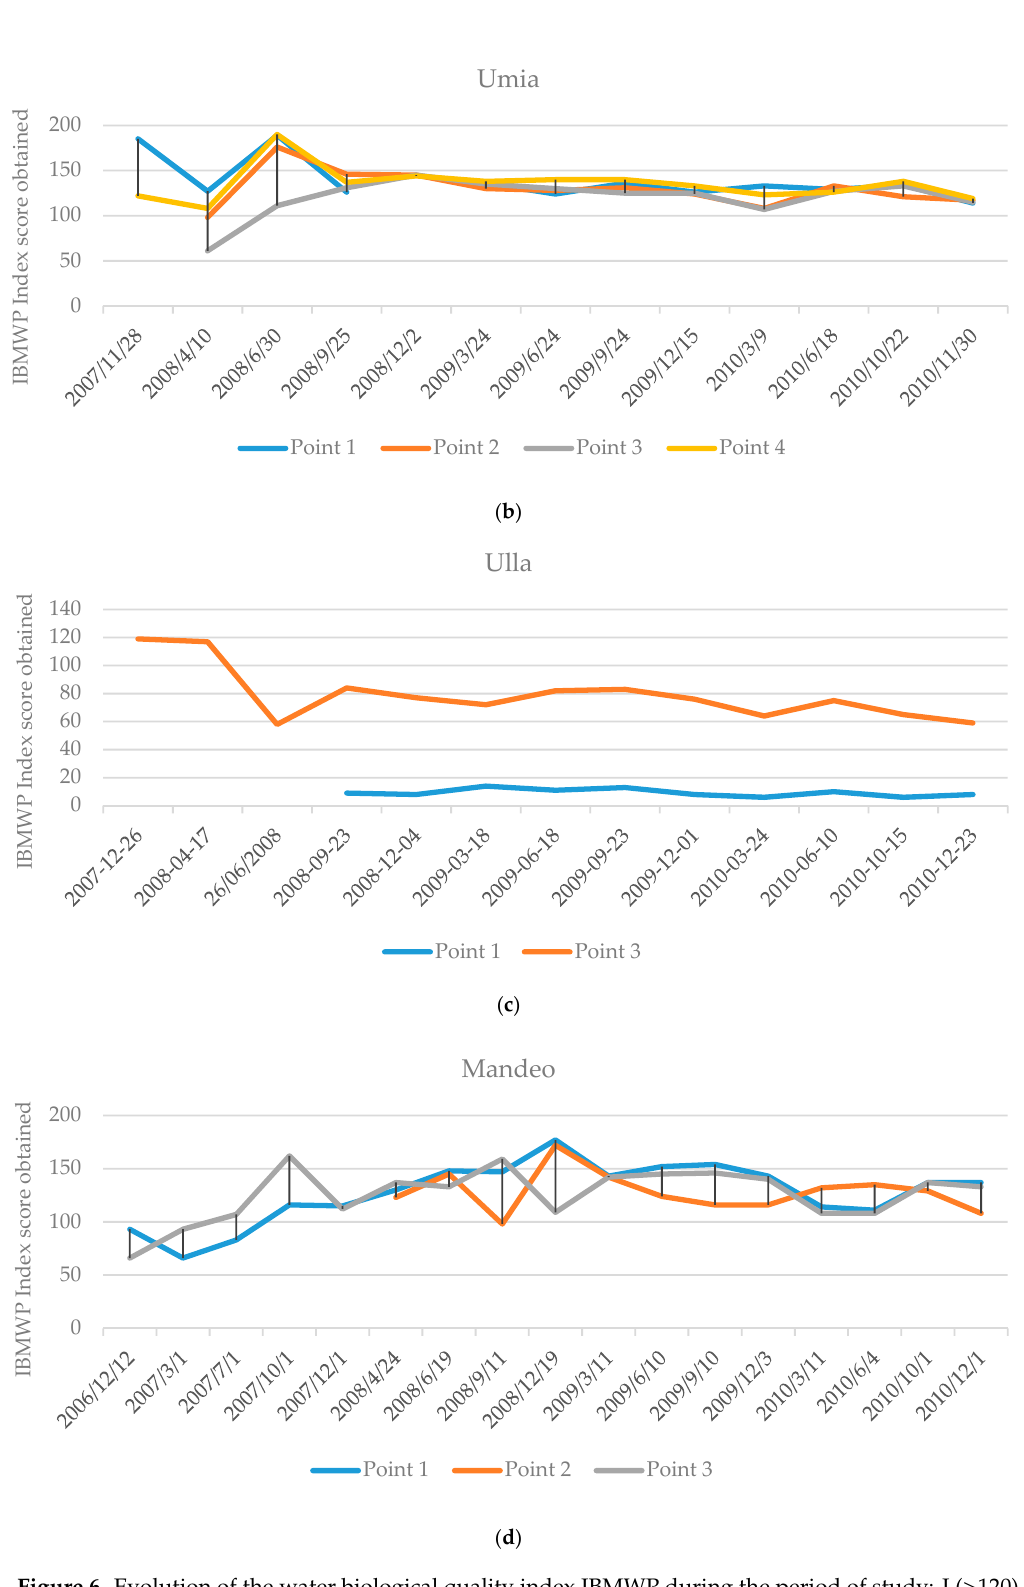
Figure 6. Evolution of the water biological quality index IBMWP during the period of study: I (>120) very clean waters; I (101–120) unpolluted or not considerably altered water; II (61–100) moderate effects of pollution are evident; III (36–60) polluted water; IV (16–35) very polluted water; V (<15) heavily polluted water, at ( a ) Lerez (San Xusto plant), ( b ) Umia (Hermida plant), ( c ) Ulla (Touro plant) and ( d ) Mandeo (Gomil plant).